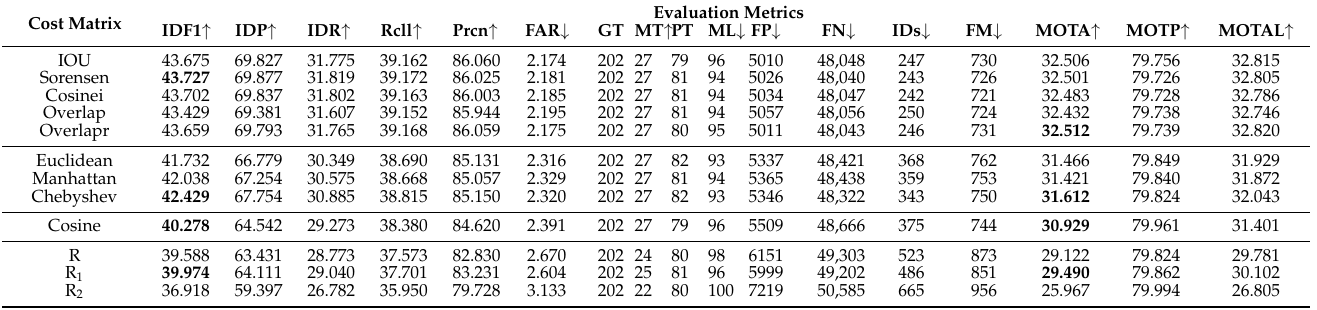
Table 1. Evaluation of Deep-SORT using our proposed data association cost matrices on the MOT17 dataset.